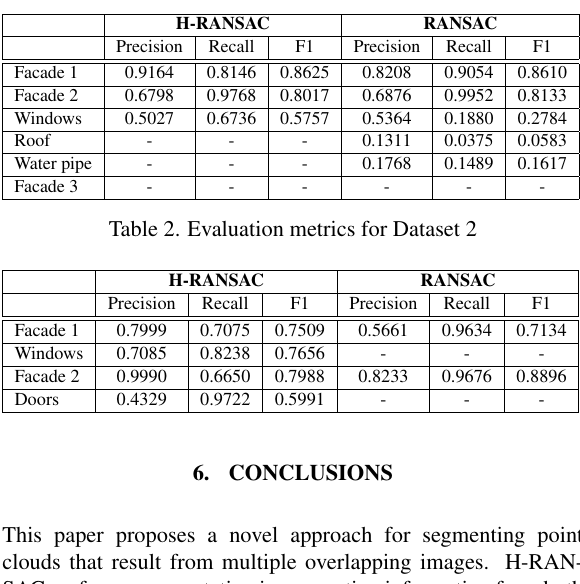
Table 1. Evaluation metrics for Dataset 1